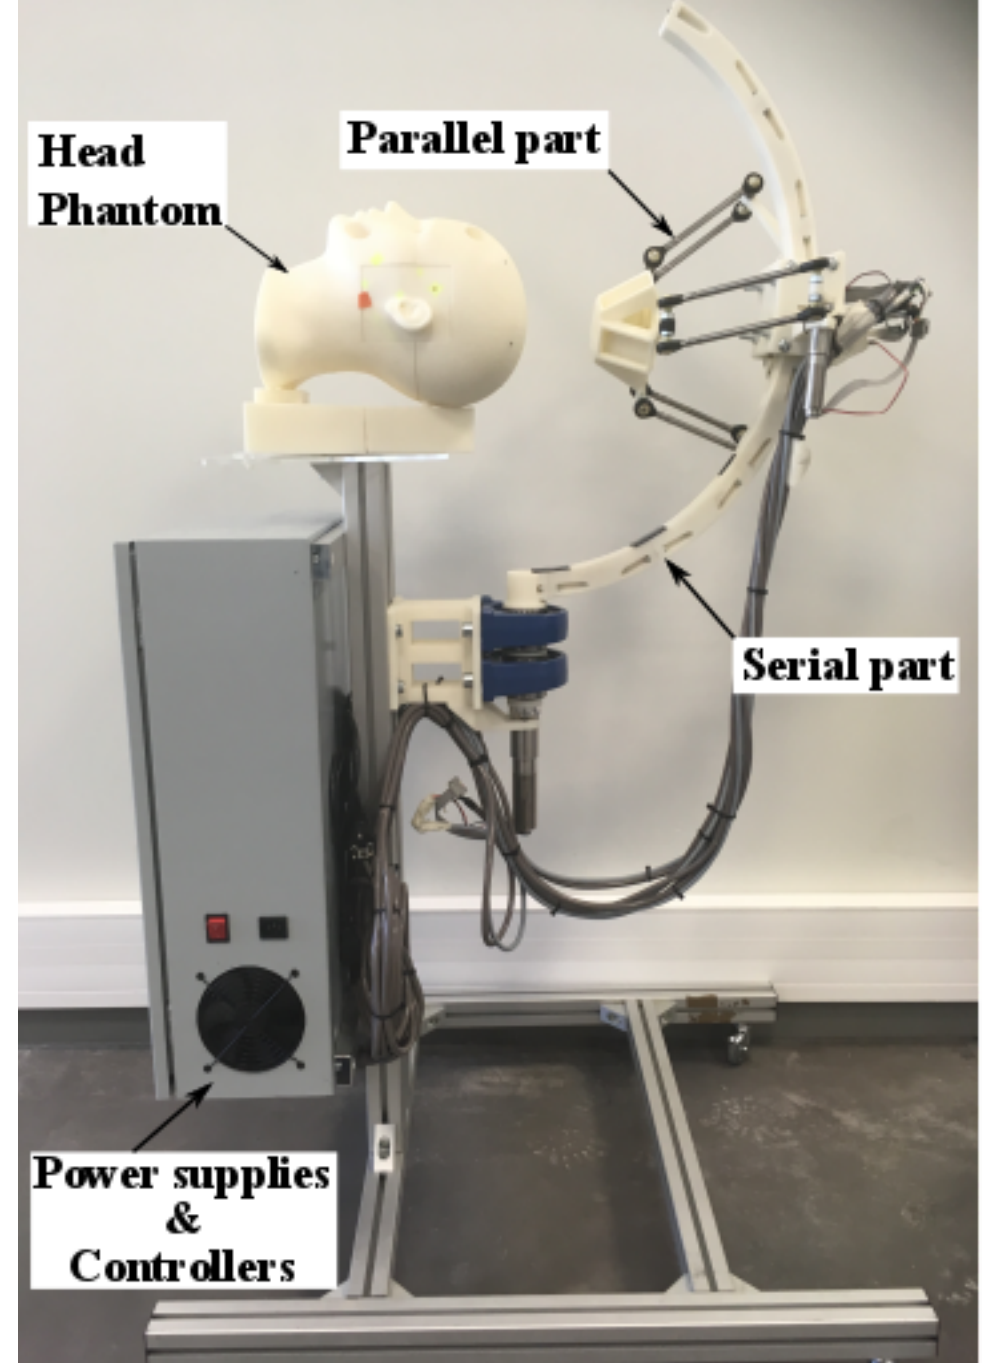
Figure 35. CochleRob manipulator